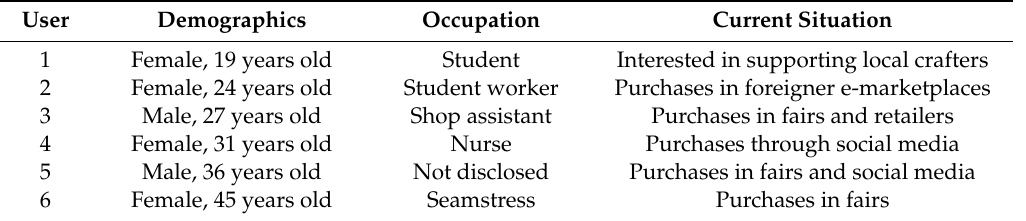
Table 2. Buyer sample. Self-source, 2020.